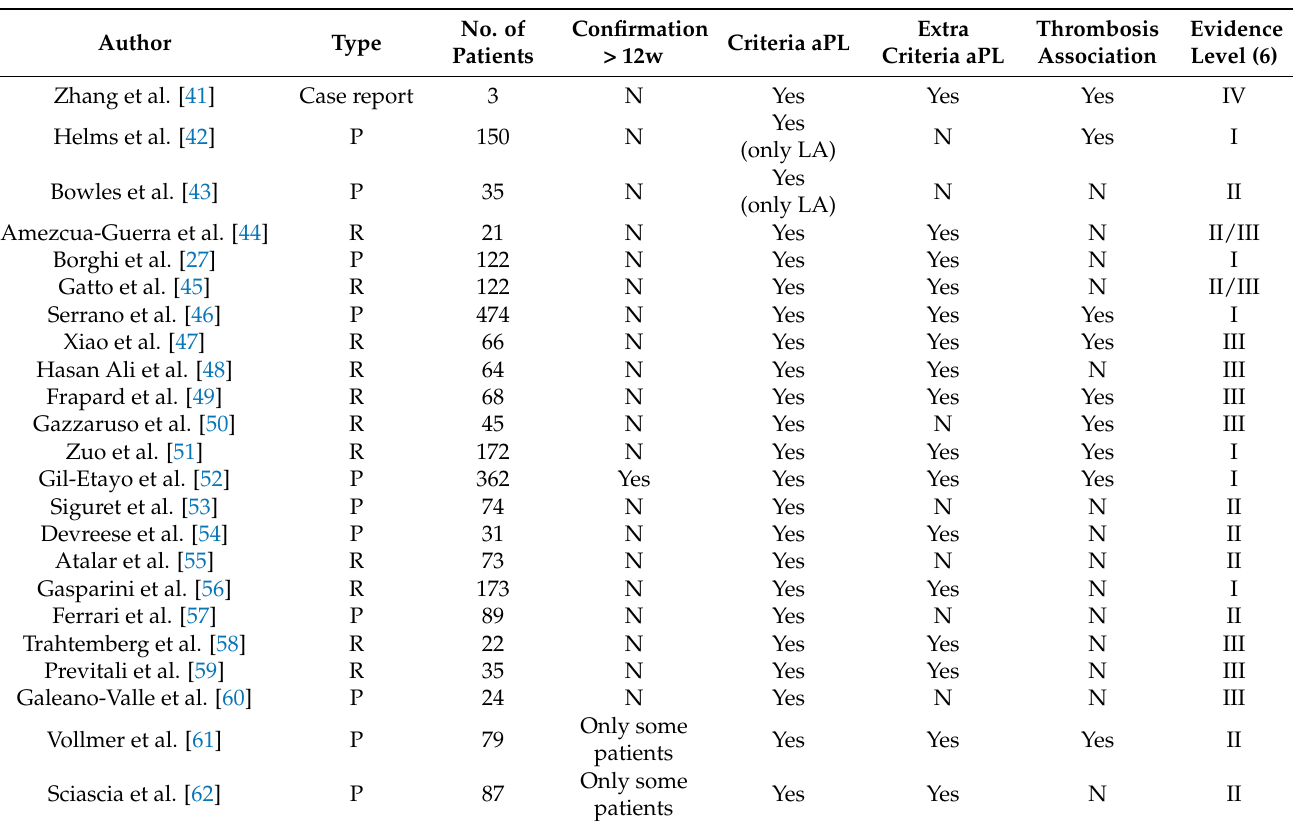
Table 1. Set of studies on aPL presence in COVID-19 patients. The prevalence and types of aPL, con- firmation after 12 weeks and the association with thrombosis were analyzed. LA: lupus anticoagulant; R: Retrospective; P: Prospective; Evidence level: According to Miyakis et al.